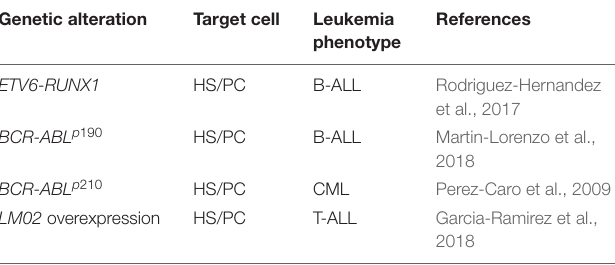
TABLE 1 | Driving of leukaemia by a malignant epigenetic stem cell priming. Genetic